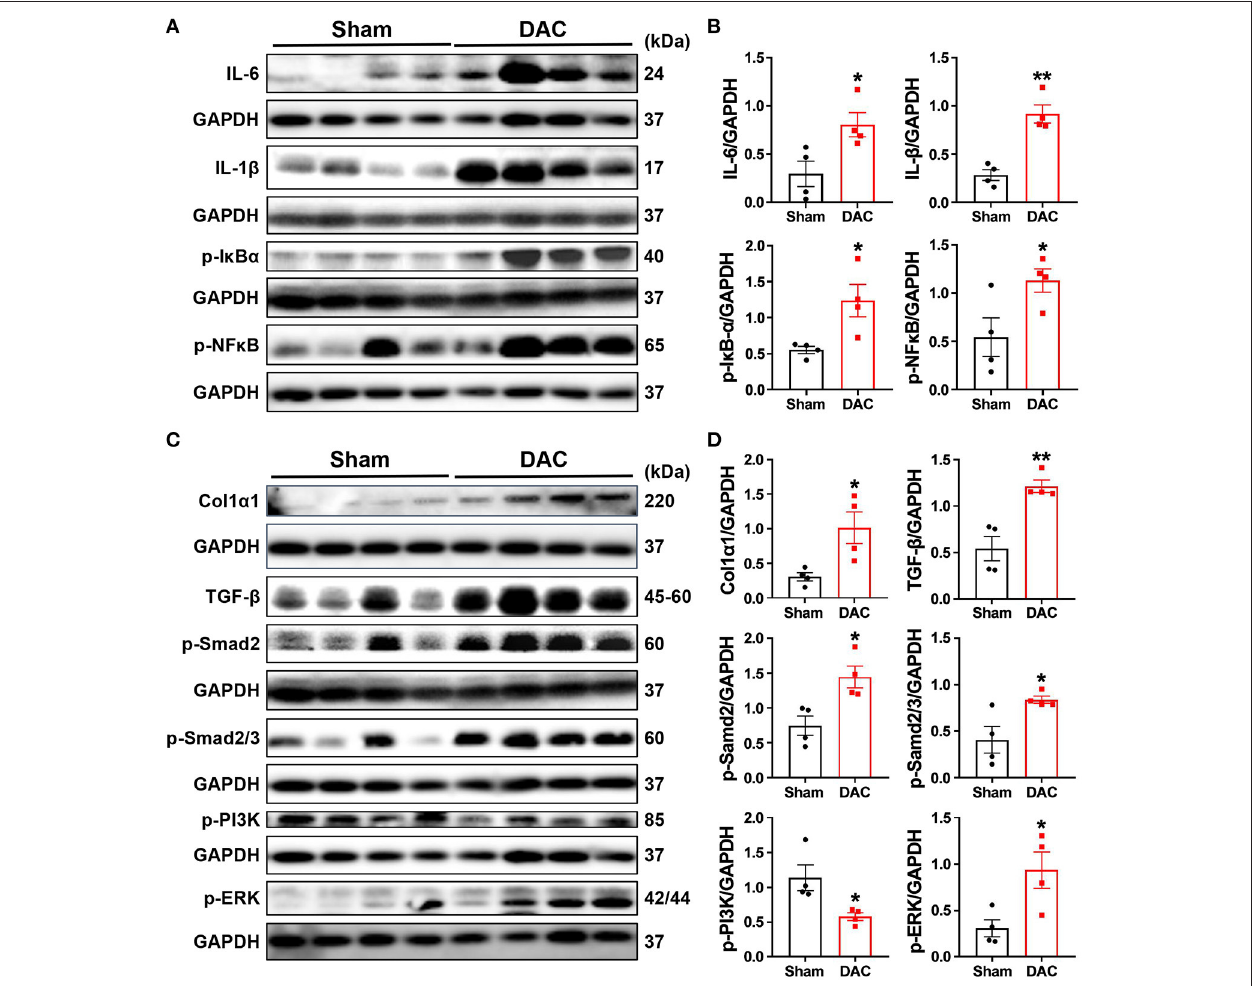
FIGURE 8 | Activation of the inflammatory and fibrotic pathways. This study demonstrates that myocardial fibrosis is associated with activation of inflammatory pathways as the evident elevation of p-I κ B α , p-NF κ B, IL-6, and IL-1 β in the DAC myocardium (A,B) and significant increases in the levels of fibroblast-secreted TGF- β 1, the downstream effectors p-Smad2 and p-Smad2/3, and p-PI3K and p-ERK linking to cellular proliferation following DAC (C,D) . n = 4 minipigs per group. Each band represent an individual animal. All data are presented as the means ± SEMs. * P < 0.05, ** P < 0.01 vs. the sham